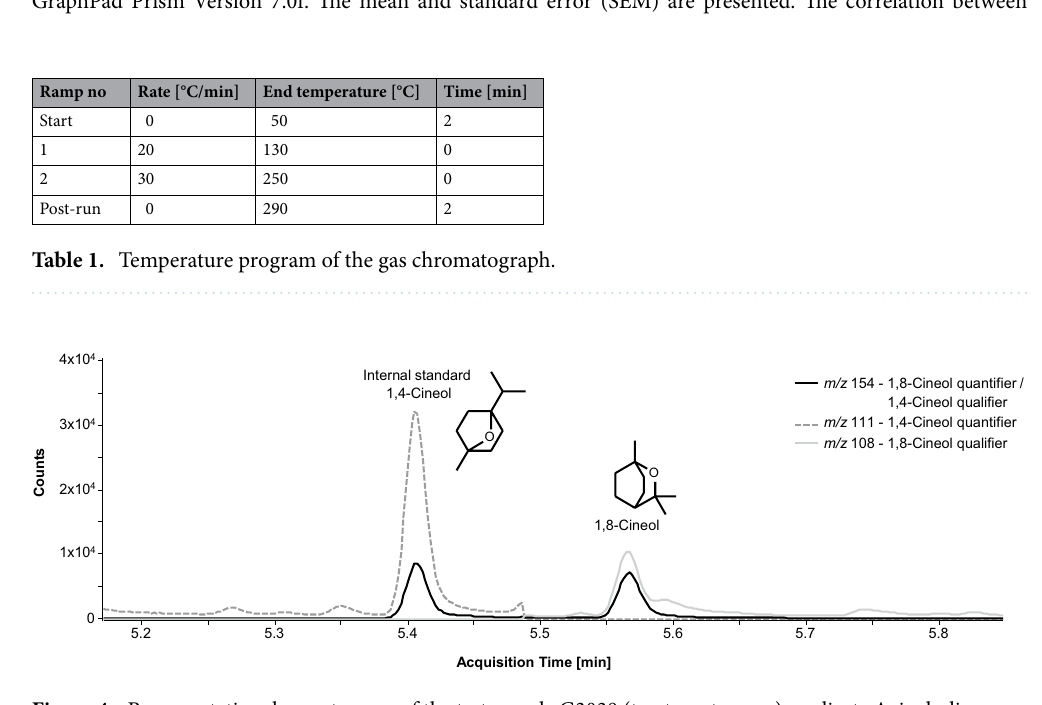
Figure 4. Representative chromatogram of the test sample G3038 (treatment group), replicate A, including the quantifier and qualifier mass transitions of 1,8-Cineol and the internal standard 1,4-Cineol and chemical structures of both